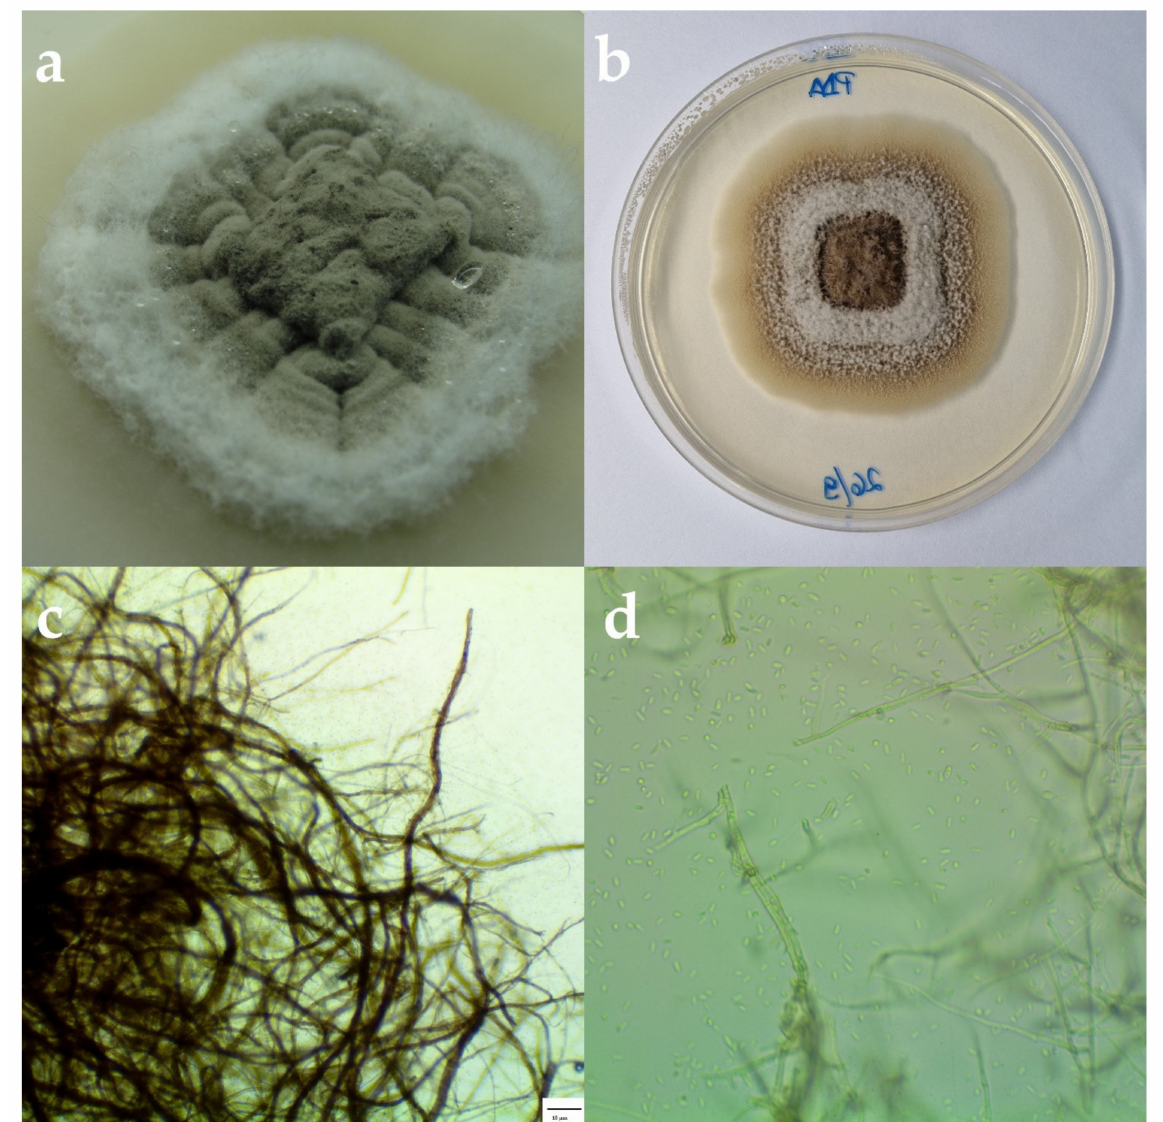
Figure 2. ( a ) Phaeoacremonium iranianum colony, on PDA, after two weeks in the dark at 25 ◦ C. ( b ) P. iranianum colony, on PDA, after one month. ( c ) Micrographs of P. iranianum isolate under the microscope. Scale bar = 10 µ m. ( d ) Hyaline, ovoid